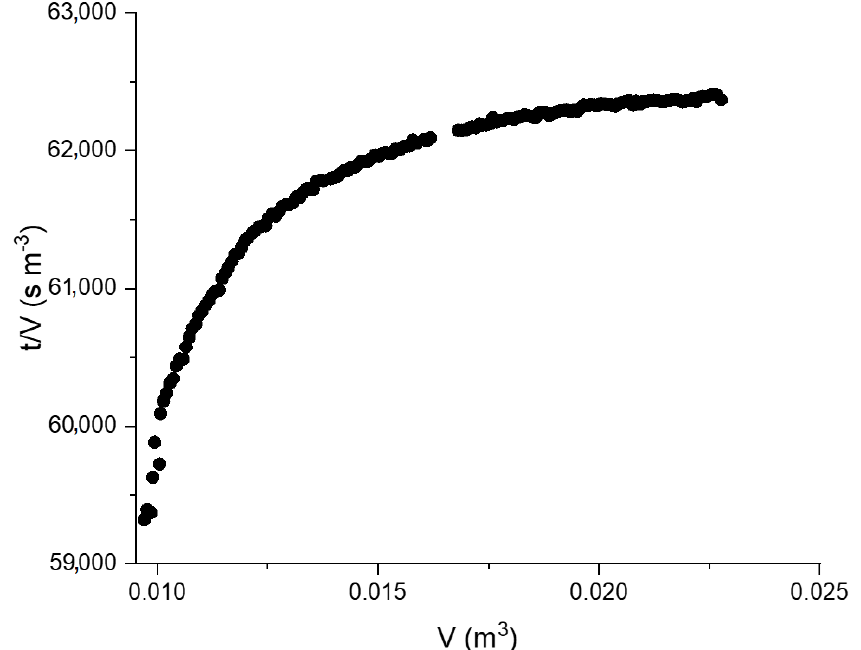
Figure 9. t/V versus V plot for the commercial crossflow filtration experiment at 0.5